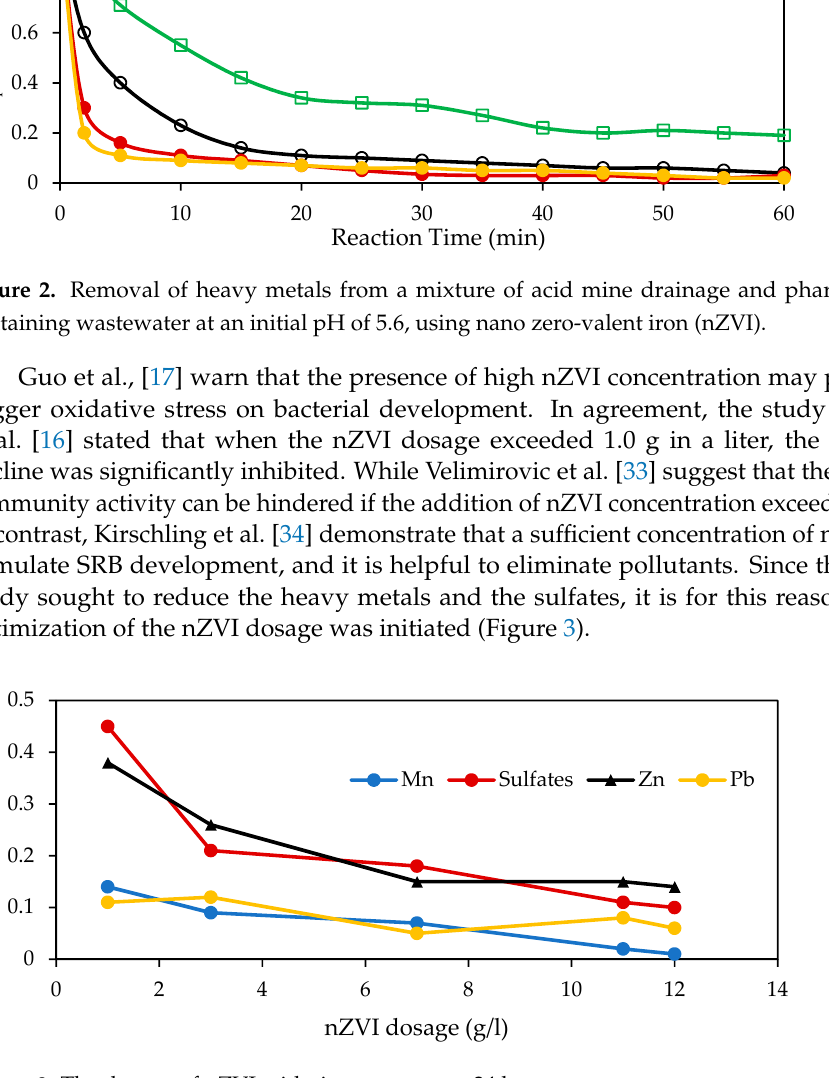
Figure 3. The dosage of nZVI with time testes over 24 h.